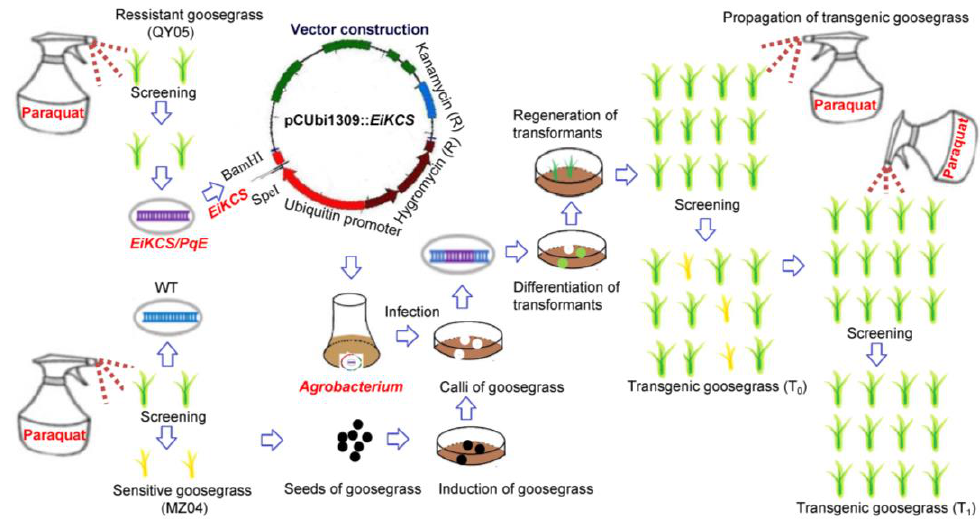
Figure 7. The graphical overview of the vector construction and transformation system for goose- grass.